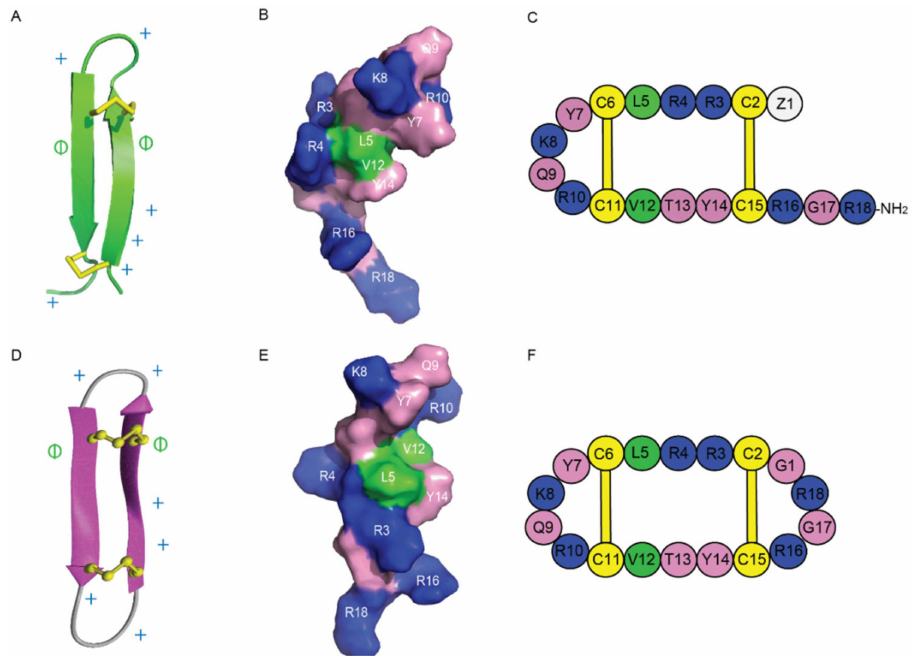
Figure 6. Structures of Gm and cGm. ( A ) Ribbon representation of the β -hairpin structure of Gm with disulfide bonds highlighted in yellow. PDB structure ID: 1KFP. ( B ) Surface representation of Gm. Non-polar (hydrophobic) residues are shown in green, polar residues in pink, and positively charged residues in blue. ( C ) A schematic view of Gm sequence. ( D ) Three-dimensional structure of cGm. Disulfide bonds are represented with yellow ball and sticks, and two antiparallel β -sheets are shown in purple. BMRB ID: 17986. ( E ) Surface representation of cGm. Non-polar (hydrophobic) residues are shown in green, polar residues in pink, and positively charged residues in blue. ( F ) A schematic view of cGm sequence. Positively charged residues are indicated with a ‘+’ symbol, hydrophobic residues are indicated with a ‘ Φ ’ symbol on ( A , D